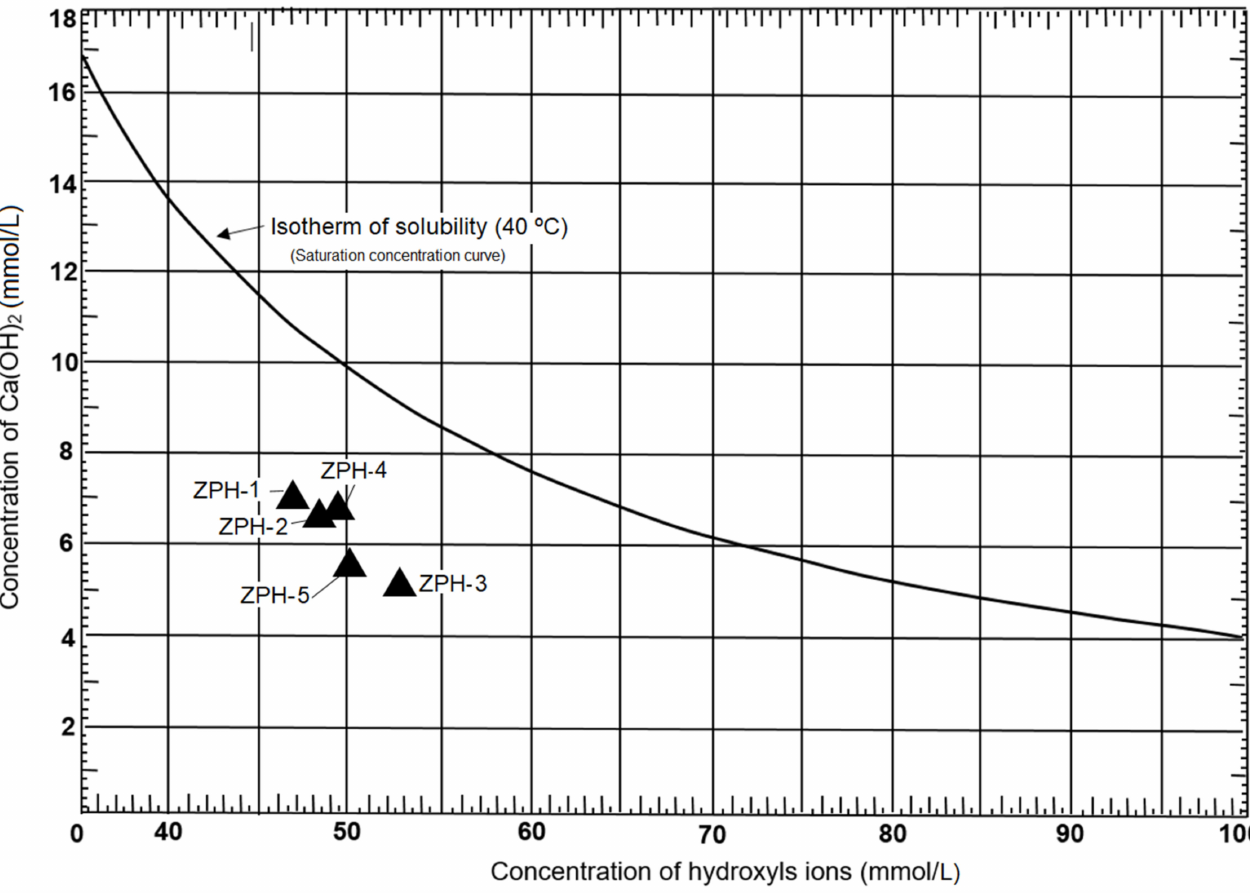
Figure 6. Pozzolanic reactivity of the